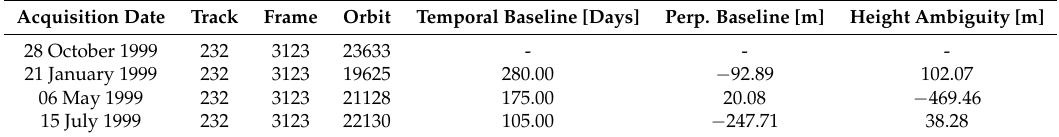
Table 1. ERS-2 data used in this study.